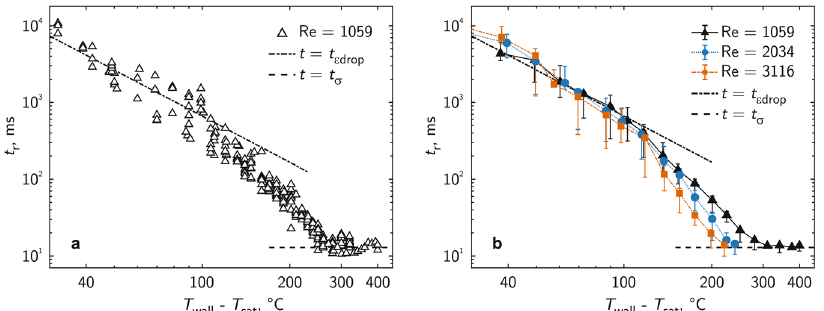
Fig. 2 Parametric study of the residence time of an impacting water drop on a hot steel target. a Experimental results on the residence time t r of impacting drops with a Reynolds number Re (cid:1) ρ d 0 U 0 = μ ¼ 1054, with ρ and μ being the liquid density and viscosity, d 0 the initial drop diameter and U 0 the impact velocity. Each symbol corresponds to a single drop impact onto a steel target with various initial temperatures. The impact parameters are d 0 = 2.3 mm and U 0 = 0.46 m s − 1 . The experimental data are compared to theoretical estimations of the total evaporation time of a deposited drop t ϵ drop and natural oscillation time t σ . b Residence time t r averaged over a target temperature class for different impact velocities. Each experimental point is the average value of ten experiments for the corresponding temperature class. The error bars represent one standard deviation ± s . The experimental residence time is shown in comparison to the theoretical models t ϵ drop and t σ .